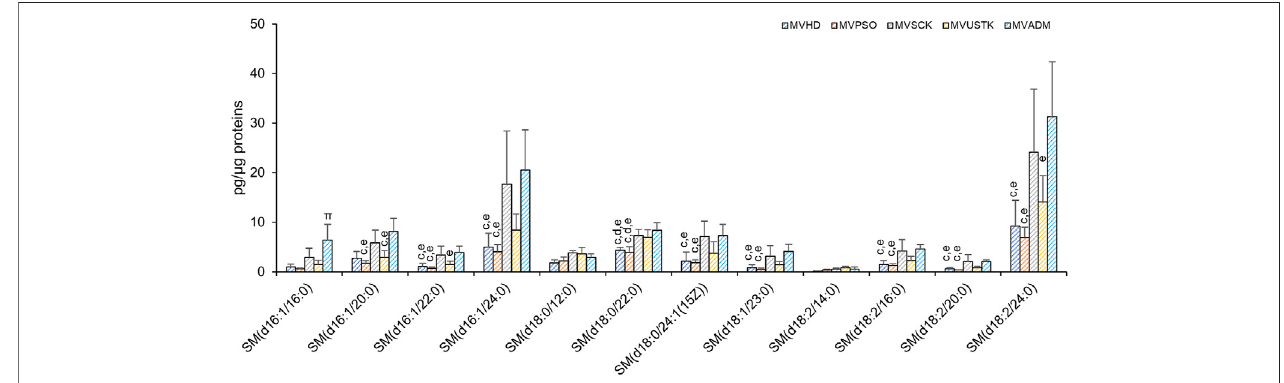
FIGURE6| MolecularspeciesofSMdetectedinMVisolatedfromplasmaofHD,PSOandPSOtreatedwithSCK,USTKandADM.Lipidextractswereanalysedby LC/MS-MS. The amounts of detected SMs were expressed as pg of lipid species/ μ g of proteins. Data are reported as mean ± SD; p < 0.05 was considered statistically signi fi cant by one-way ANOVA and Tukey ’ s post-hoc analysis; columns with different letters are signi fi cantly different (i.e. a vs. HD, b vs. PSO, c vs. SCK, d vs. USTK, e vs. ADM and π vs.